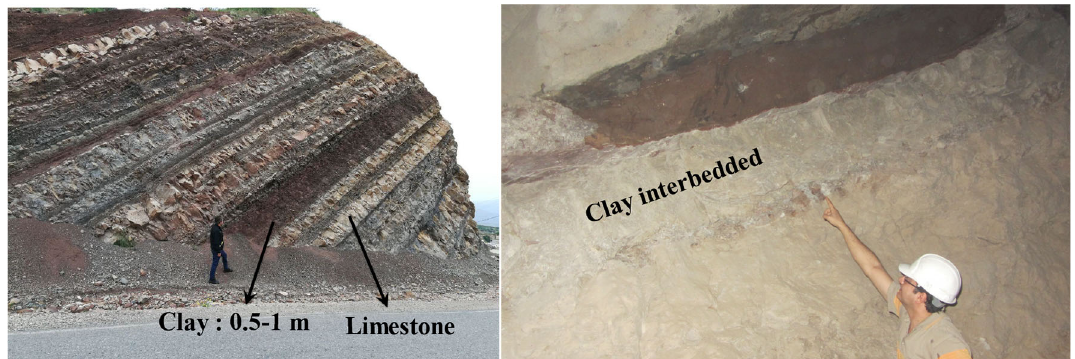
Fig. 9 Clayey interbeds in the study